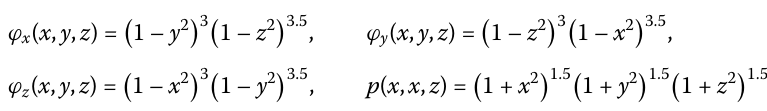
L 2 - norm for the vorticity and pressure. We observe that the errors tend to 0 when N in- creases, which confirms the result in ([11], Sect. 5,